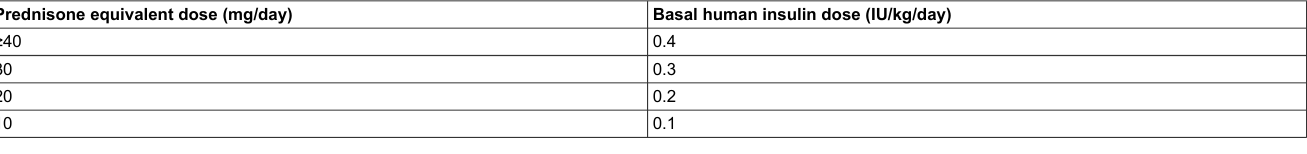
Table 3: Insulin dose according to weight and glucocorticoid dose. Prednisone equivalent dose